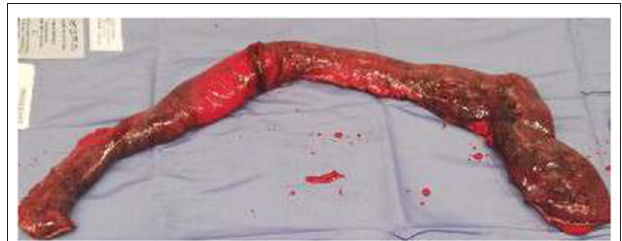
FIGURE 2 | Macroscopic aspect of the ileum resected.